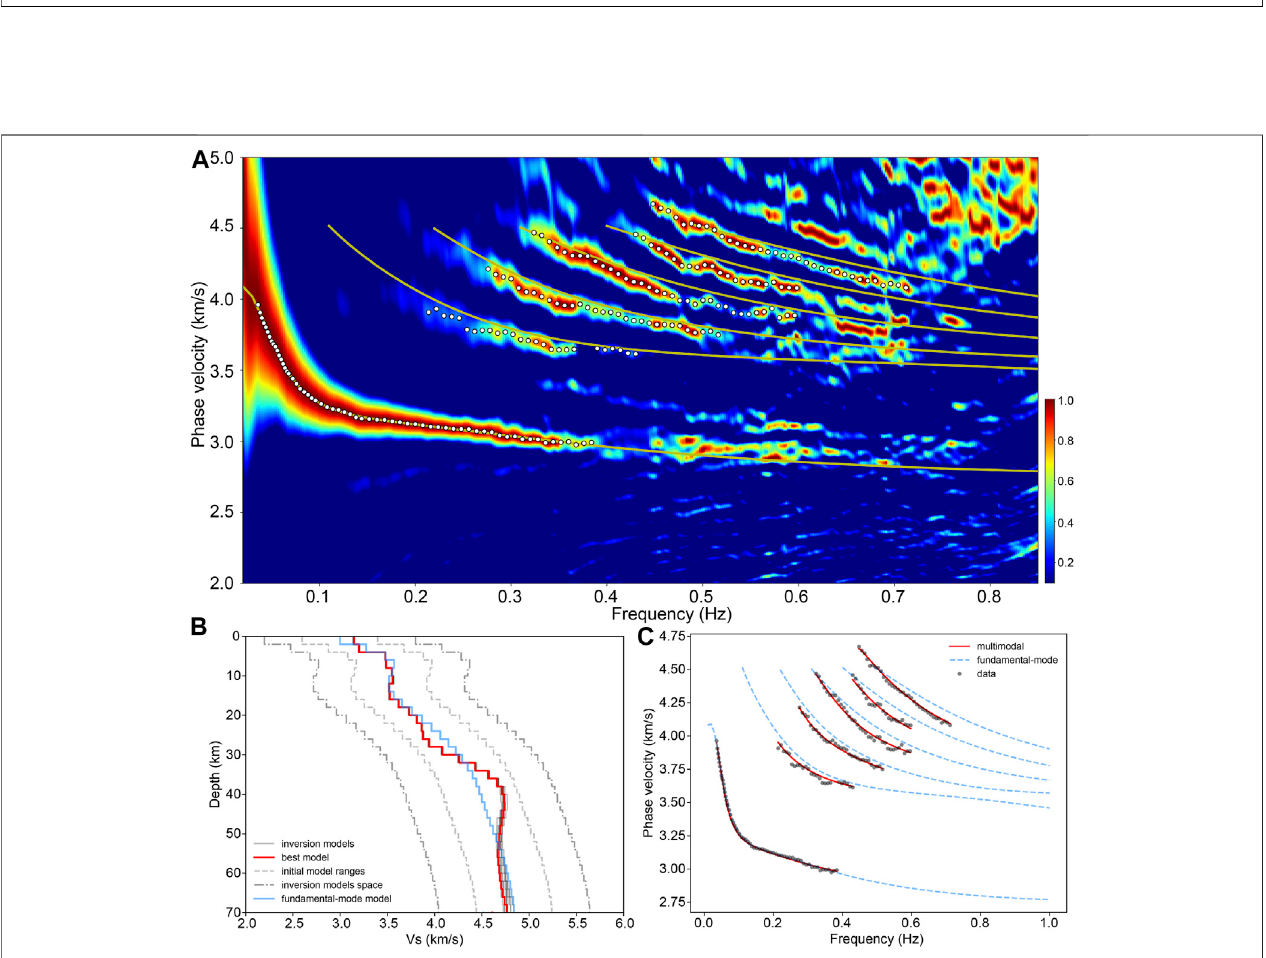
FIGURE9| Identi fi cation ofthemultimodaldispersioncurvesofsubarray 1and theinversion and fi ttingresults. (A) TheF-Jspectrogramofseismicarray “ subarray 1 ” . (B) and (C) The inversion and fi tting results of the multimodal dispersion curves.